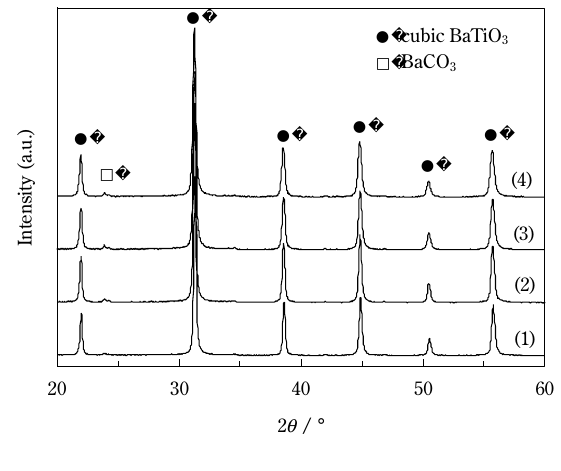
Fig. 9 TG curves of BaTiO 3 particles prepared by sol-gel method with different mixing